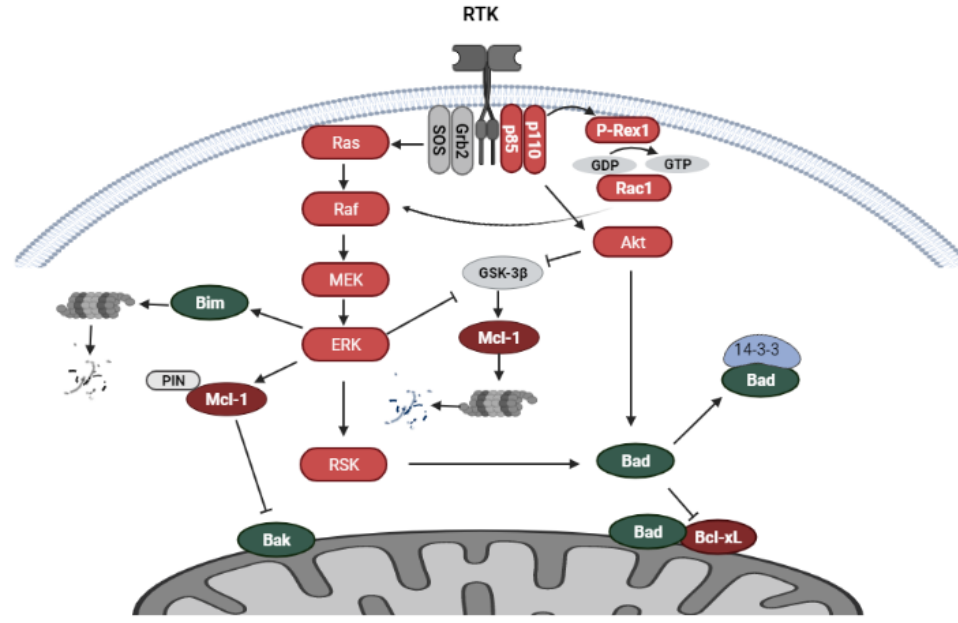
Figure 4. The regulation of Bcl-2 family proteins through PI3K/Akt and MAPK pathways in breast cancer cells. The BH3-only protein Bim is a target of ERK, which induces its phosphorylation leading to its proteasomal degradation. The activation of PI3K also leads to ERK-mediated Bim phosphorylation. This is facilitated through the guanine exchange factor for Rac1, P-Rex1, which induces Rac1/Raf/MEK/ERK/Bim signaling. Mcl-1 is a target of both ERK and Akt and is stabilized through the phosphorylation and inactivation of GSK3 β . Additionally, ERK phosphorylates Mcl-1 enabling its stabilization by the isomerase Pin1 and inhibition of Bak. ERK and Akt also target the pro- apoptotic protein Bad. Phosphorylation of Bad recruits 14-3-3 proteins, which blocks its association with Bcl-xL at the mitochondria. Created with BioRender.com (accessed on 5 December 2021). ER signaling has also been shown to mediate the crosstalk between the PI3K/Akt and MAPK/ERK pathways in the regulation of the Bcl-2 family proteins. Estrogen inhibited apoptosis induction in MCF-7 breast cancer cells through upregulation of PI3K/Akt and MAPK/ERK signaling and phosphorylation of Bad at the Akt and ERK phosphorylation sites (Ser 136 and Ser 112). Interestingly, the inhibition of PI3K abrogated estrogen-induced ERK activation and phosphorylation of Bad at Ser 112, the ERK phosphorylation site, indi- cating crosstalk between PI3K/Akt and MAPK/ERK signaling upon estrogen